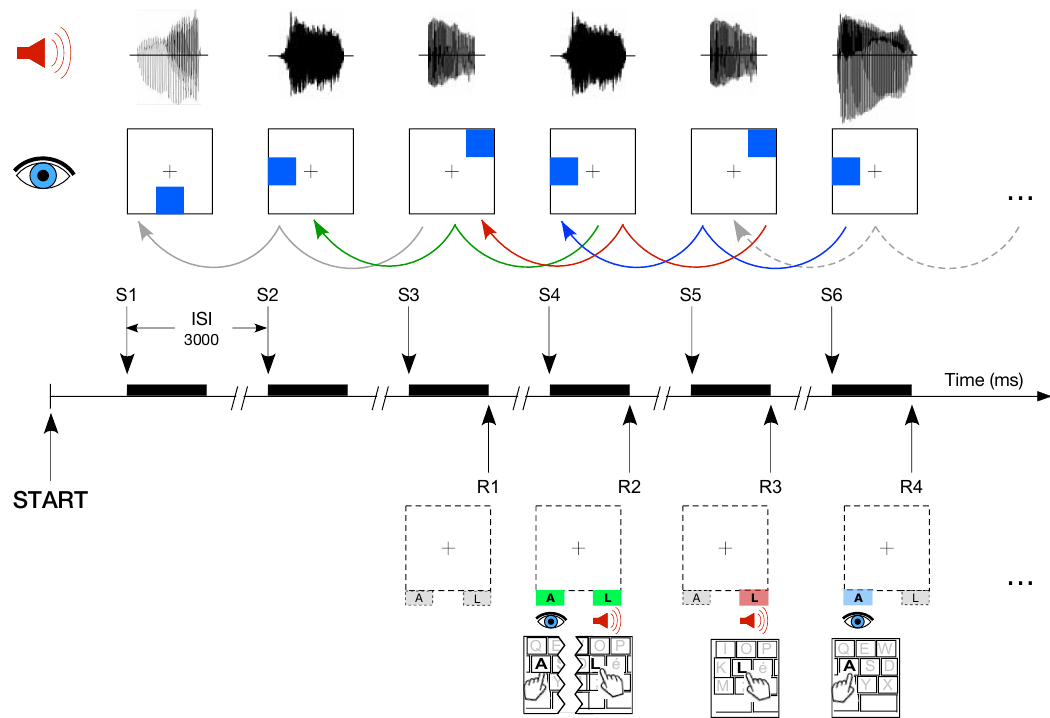
Figure 2. Example of level n = 2 of the Dual n -back task. The task consisted of 20 blocks of at least 20 trials. Each trial was composed of an auditory and visual stimulus presented